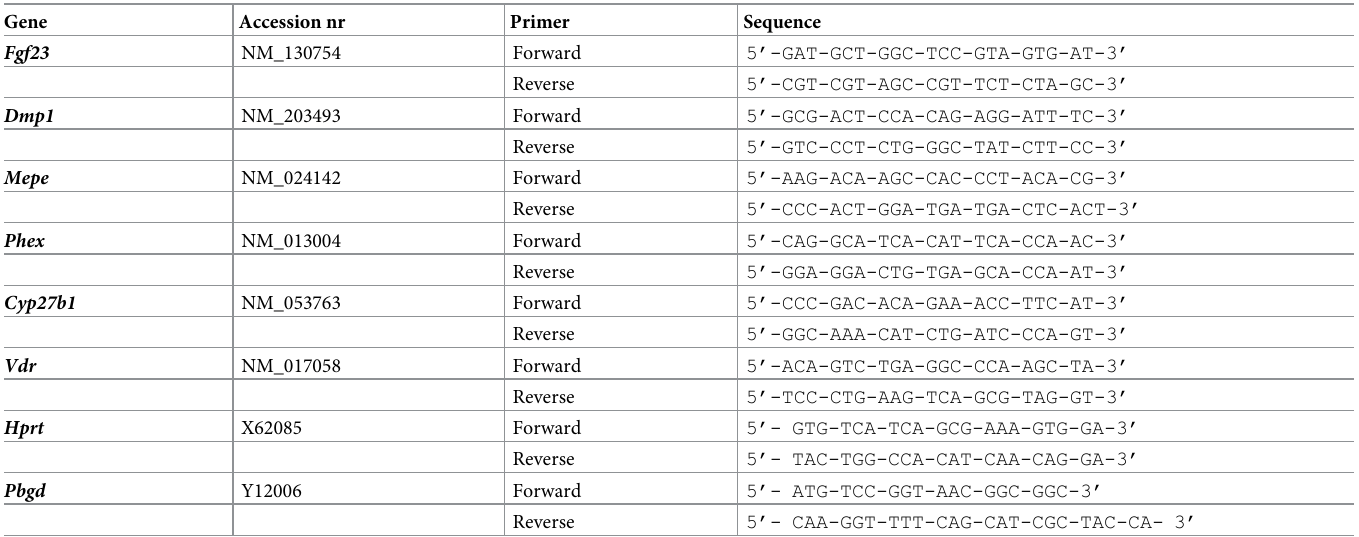
Table 1. Primer sequences for genes used in qPCR analyses.